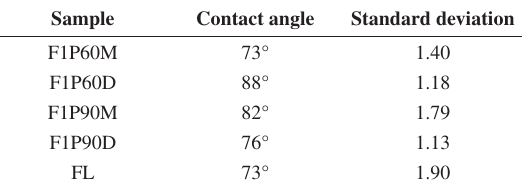
Figure 3. Layer thickness obtained for the hybrid films: (a) F1P60M, (b) F1P60D, (c) F1P90M and (d) F1P90D. Table 3. Contact angle values obtained by the sessile drop